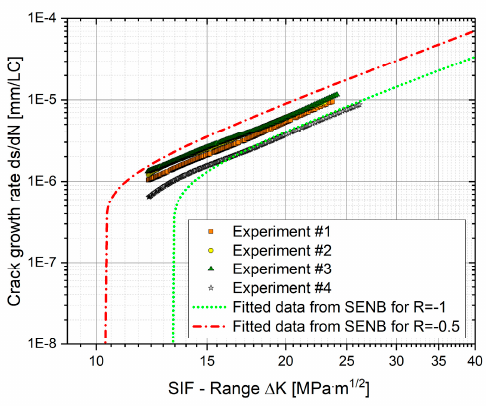
Figure 10. Comparison da/dN vs. Δ K S of round bar specimens to SENB.